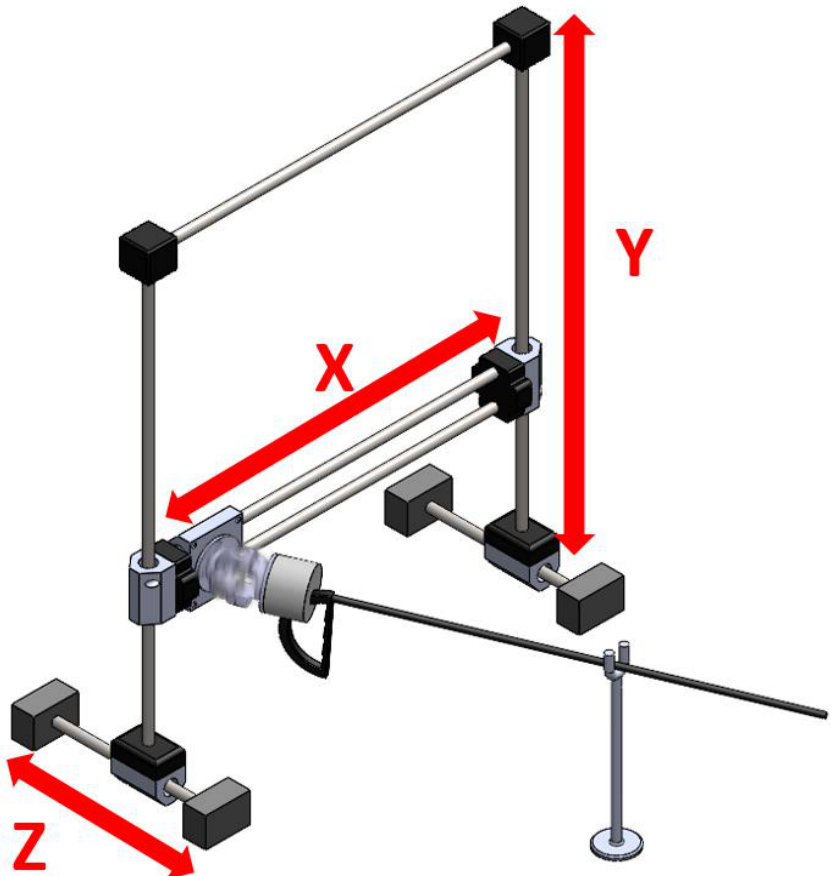
Figure 1. Conceptual idea of the surgical assistance robot.